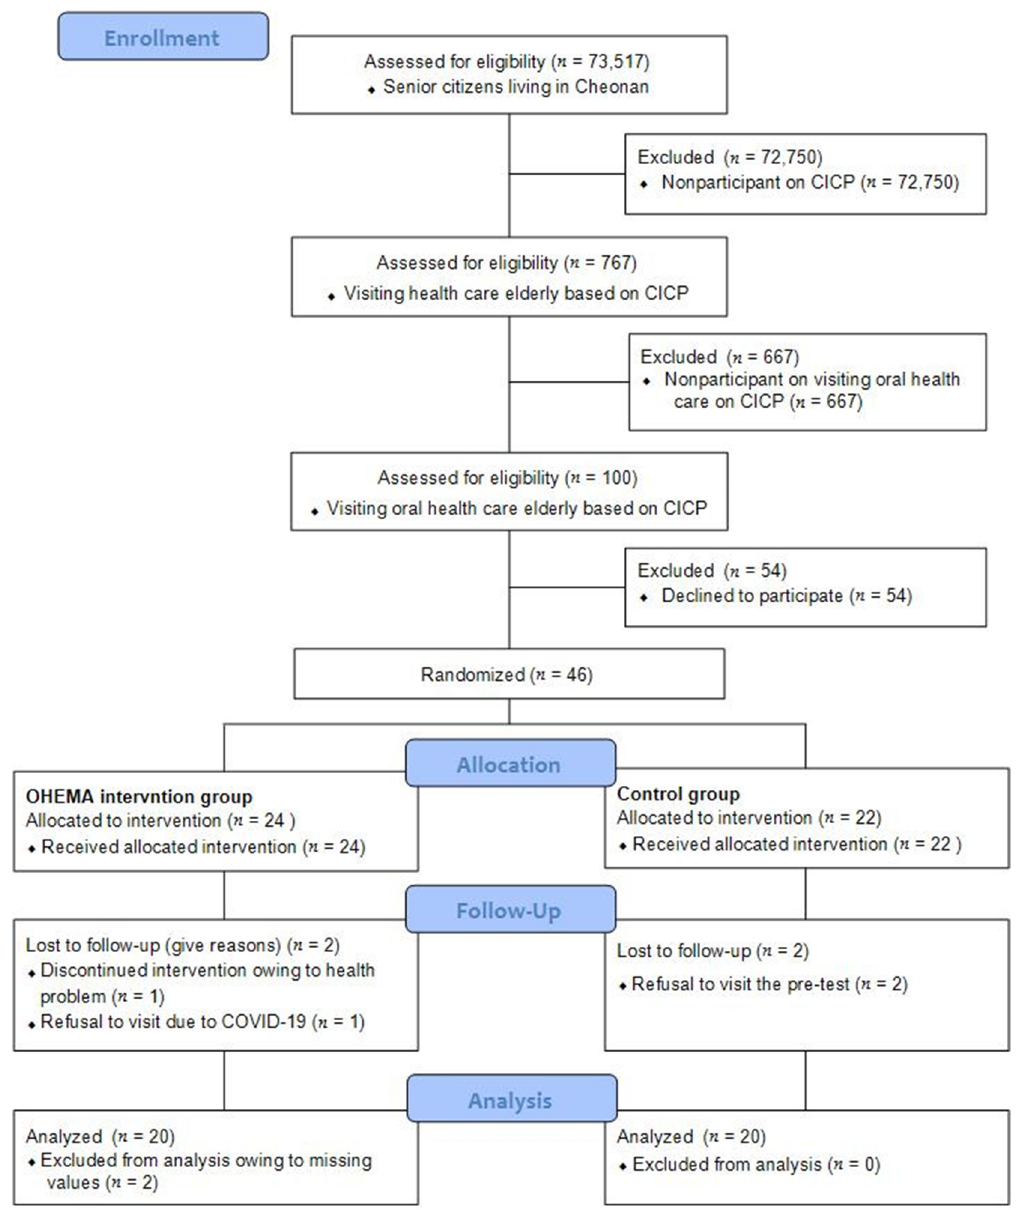
Figure 1. Consolidated standards of reporting trials (CONSORT) diagram of participants.